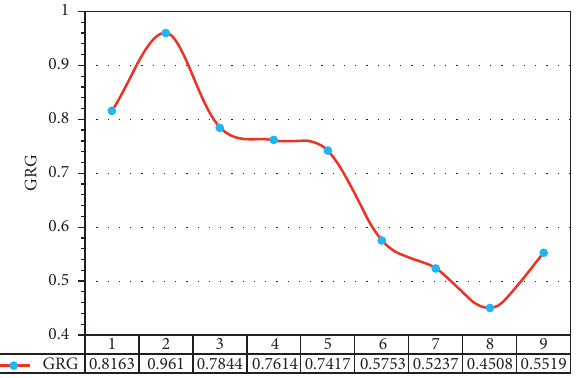
Figure 14: GRG values for the corresponding experimental order. Table 19: Model summary result.